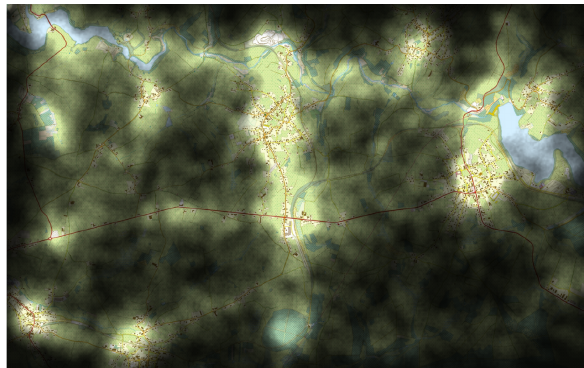
Figure 13. Focus map of all 54 participants.